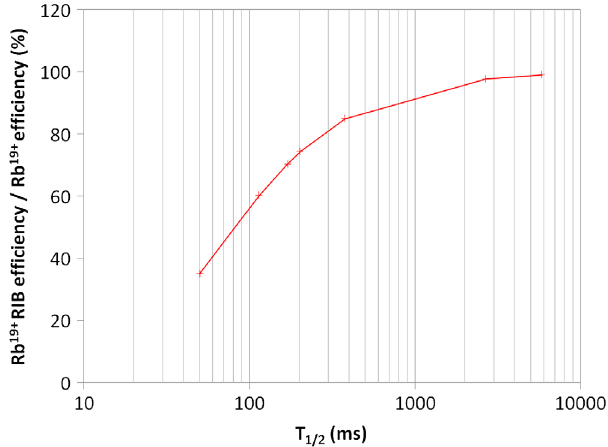
FIG. 12. Evolution of the Rb 19 þ RIB efficiency over Rb 19 þ stable efficiency ratio as a function of T 1 =